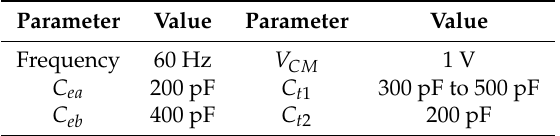
Figure 6. Simulated result of output voltage normalized to CM noise for “DTC Series” under Table 2’s condition. Table 2. Parameters of the simulated circuit components in Figure